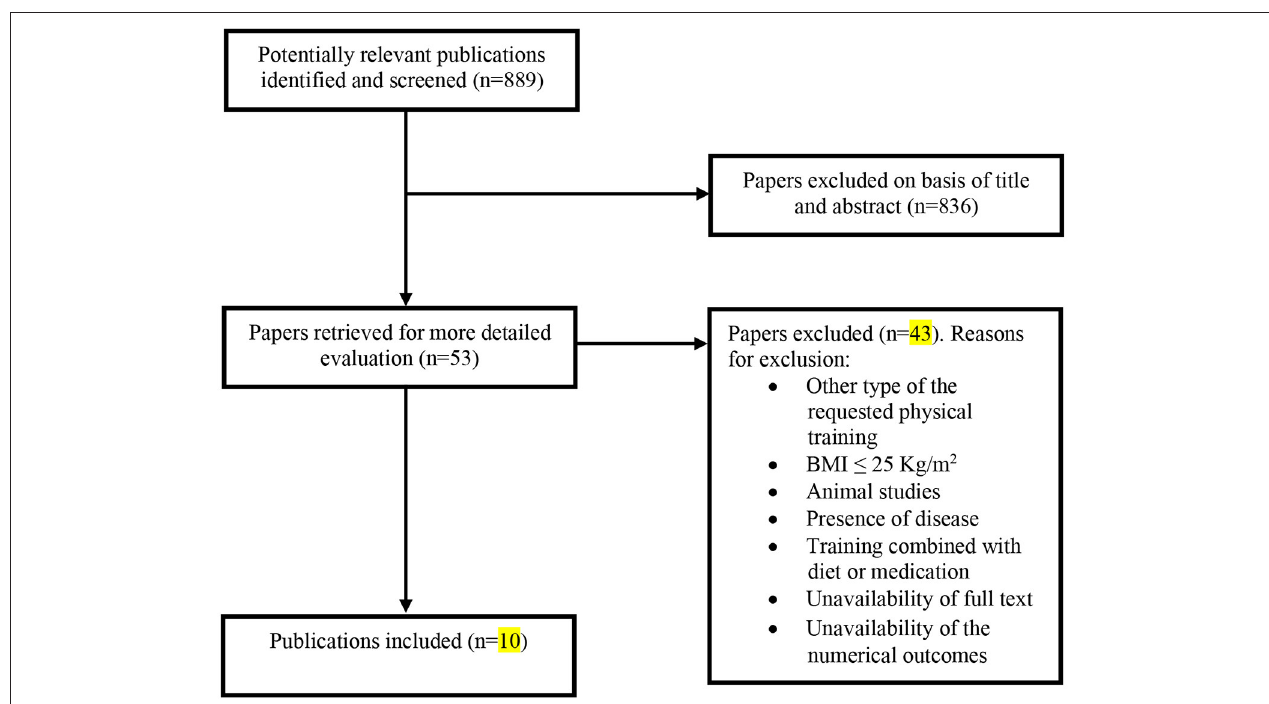
FIGURE 1 | Flow diagram for the selection of studies. Selection process for research articles (n = 10) included in this systematic review. Adapted version of the recommendations in the PRISMA (Preferred Reporting Items for Systematic Reviews and Meta-Analyses) statement (Moher et al.,